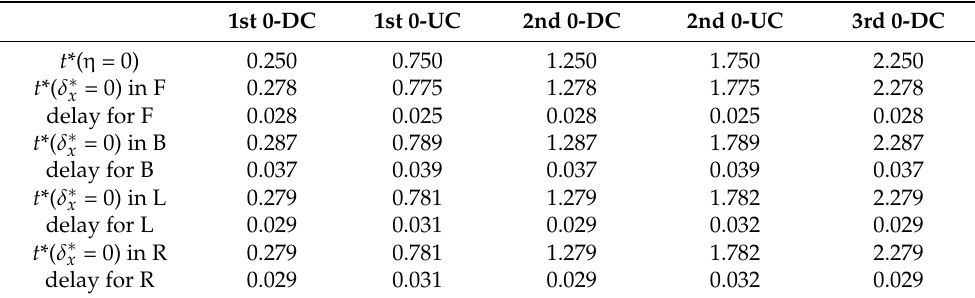
Table 2. Timing of zero down crossing (0-DC) and zero up crossing (0-UC) of the wave and of the cage displacement and